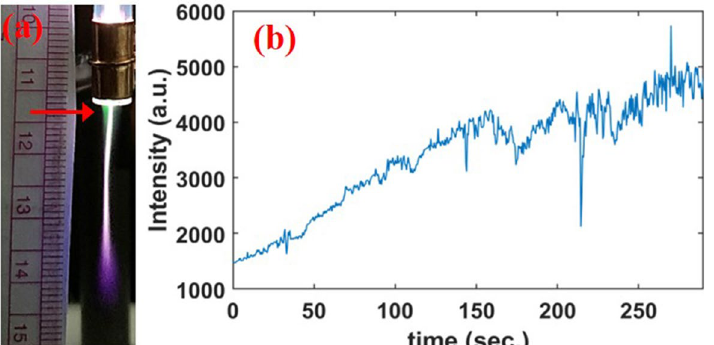
Figure 2. ( a ) Photograph of argon plasma jet in the ambient air ( V d = 10.8kV , f = 21kHz , Q Ar = 6 sL/min ,